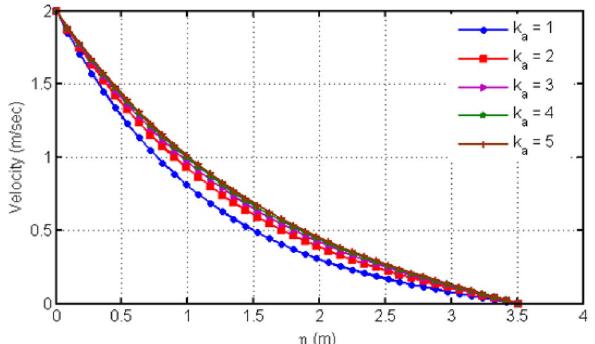
Figure 5. Variation in velocity profile for diverse values of porosity parameter Ka.